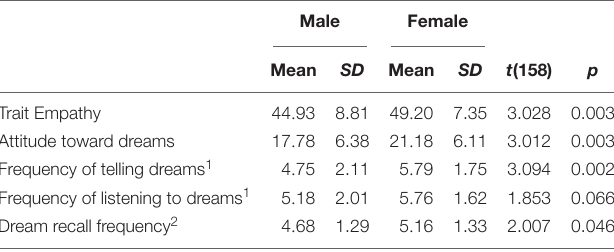
TABLE 2 | Sex differences for trait empathy and dream variables, with independent samples t -test statistics for the differences.